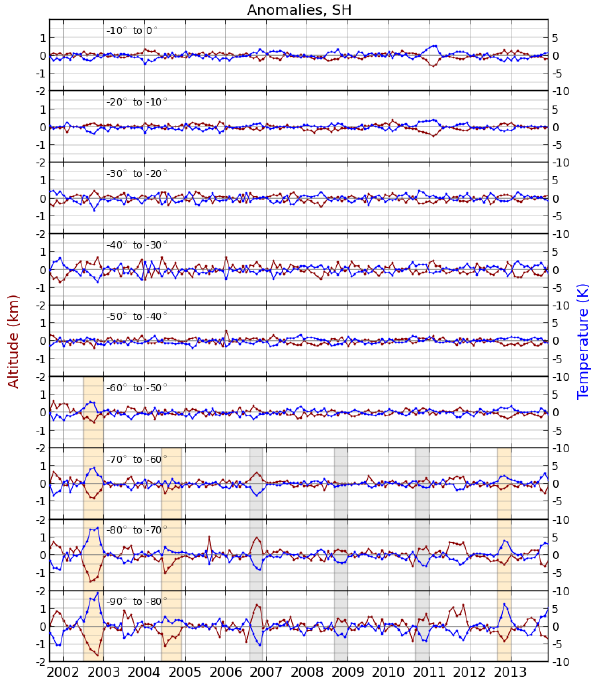
Figure 9. Anomalies of H T (red) and T T (blue) for 10 ◦ latitudinal bands in the NH. Time range: September 2001 to December 2013. Months with strong sudden stratospheric warming (SSW) events are highlighted in orange; months with very weak or no events are high- lighted in gray.